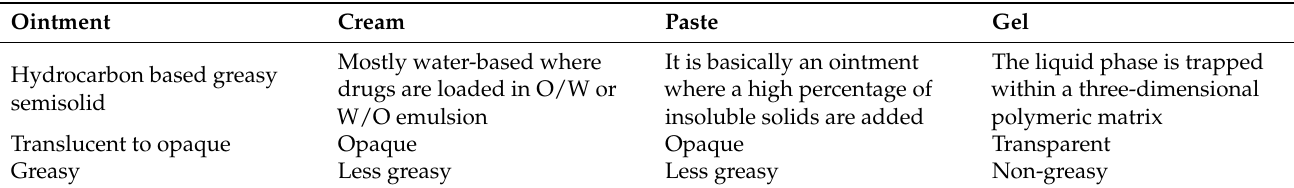
Table 2. Differences between ointment, paste, cream and